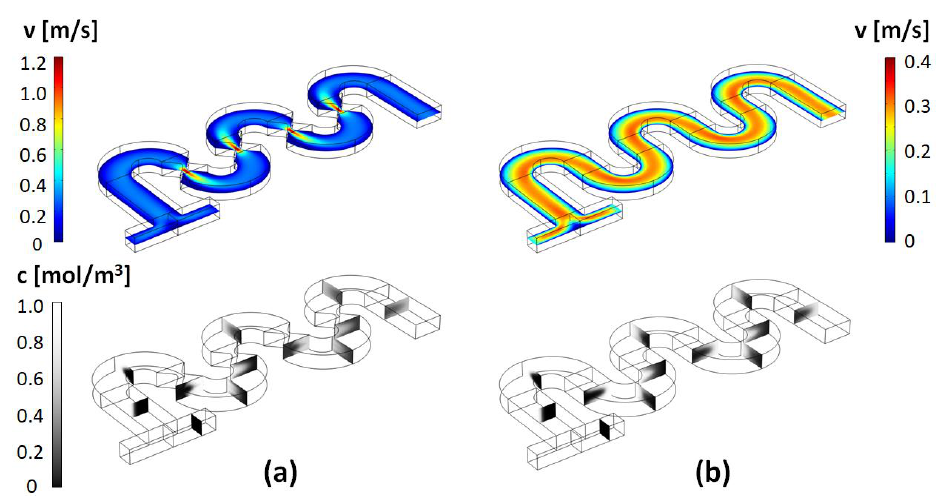
Figure 3. ( top ) Longitudinal cross-section at H/2 (middle of the channel) of the magnitude of the velocity map and ( bottom ) concentration cross-sectional maps along the channel, for: ( a ) the design with a = 20 μ m and b = 1 × a ; and ( b ) the corresponding simple serpentine channel (Reynolds number Re = 20).